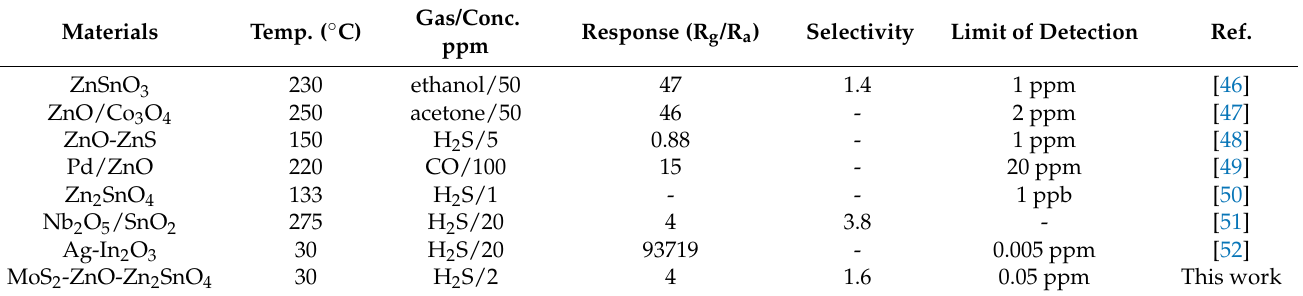
Table 1. The comparison of sensing properties between some